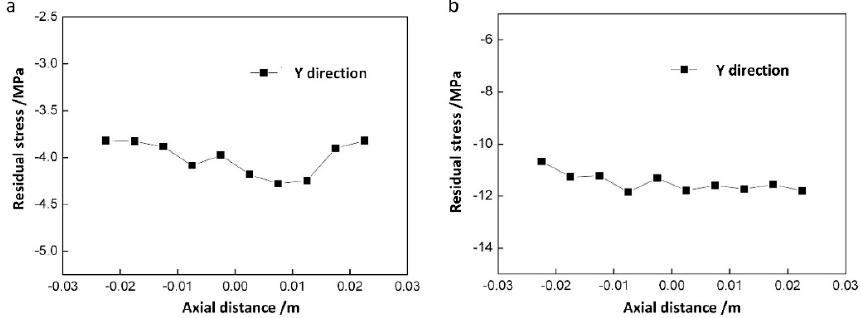
Figure 9. Radial residual stress before and after the reinforcing plate. Machining part A in Figure 1a welding. ( a ) Residual stress before butt welding. ( b ) Residual stress after butt welding.